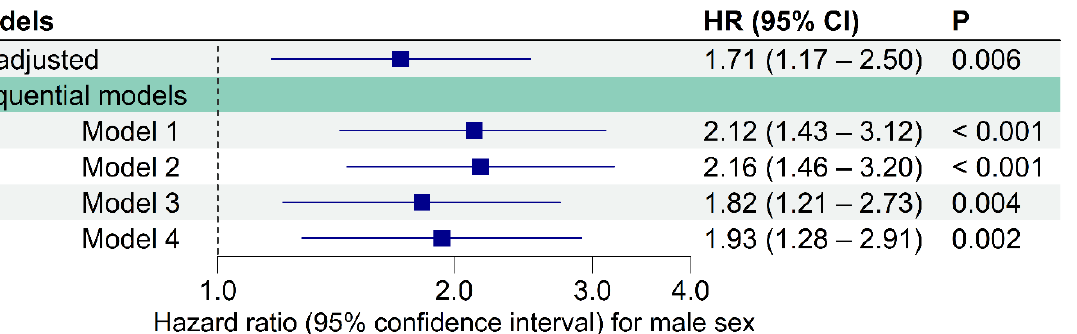
Figure 2. Ten-year mortality after surgical aortic valve replacement according to sex. HR, hazard ratio; CI, confidence interval.